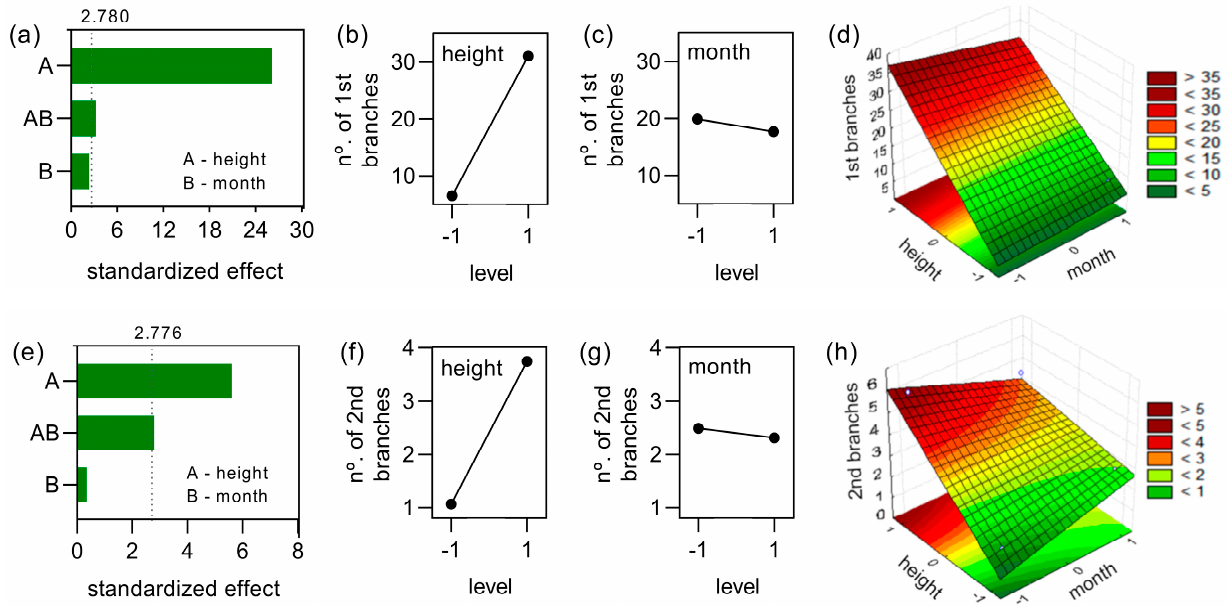
Figure 6. Factorial analysis of the experiment considering the number/plant of primary ( a − d ) and secondary ( e − h ) branches. Pareto chart of the standardized effects at p = 0.05 for number of primary and secondary branches ( a , e ). The graphs of the main effects on these responses considering variables height and month of cutting are shown in ( b , c , f , g ). Response surfaces for the number of primary branches/plant ( d ) and the number of secondary branches/plant ( h ) having as factors the height and the month of cutting of the yerba-mate plants. Table 2. ANOVA responses for number of primary and secondary branches.